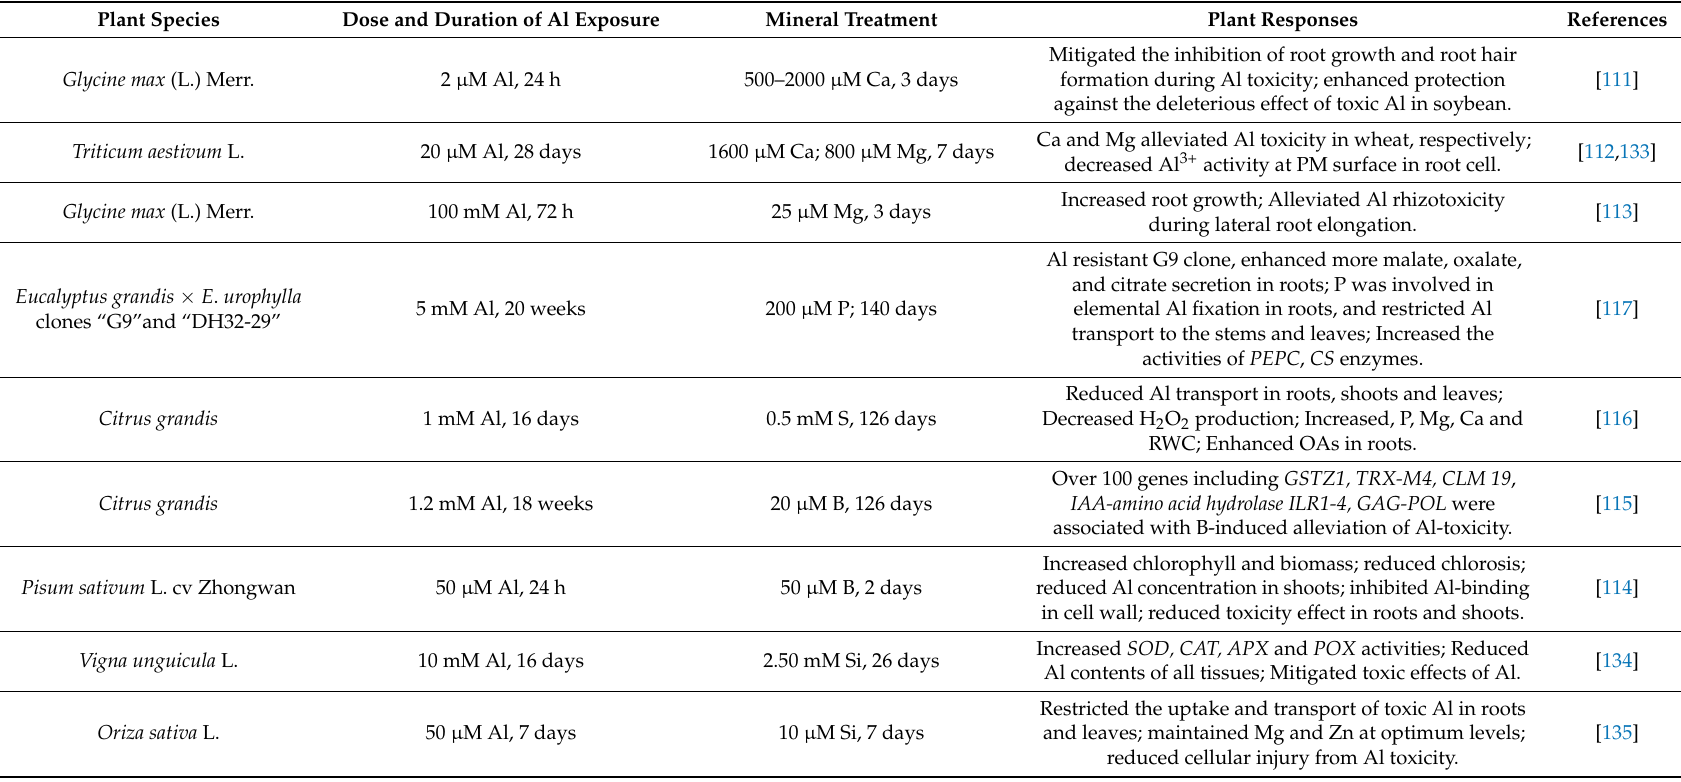
Table 5. Mineral nutrition induced protection in plants under Al